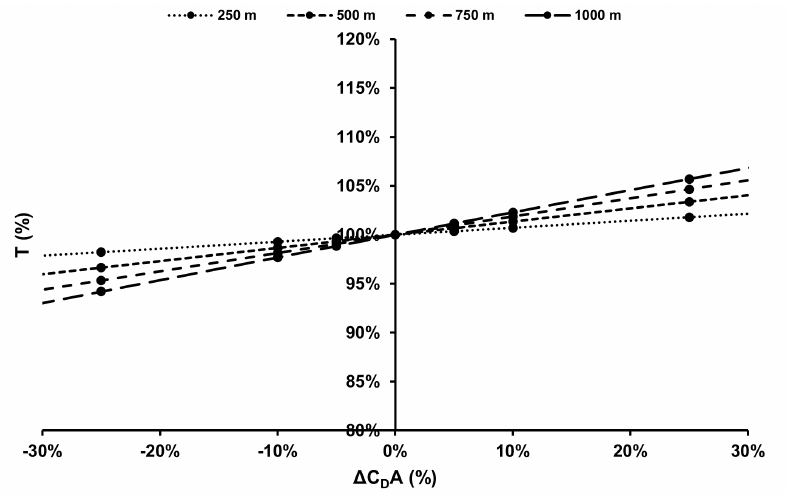
Figure 10. Change in the calculated run-time T of the generic athlete as a function of change in aerodynamic drag area c D · A for distances from 250m to